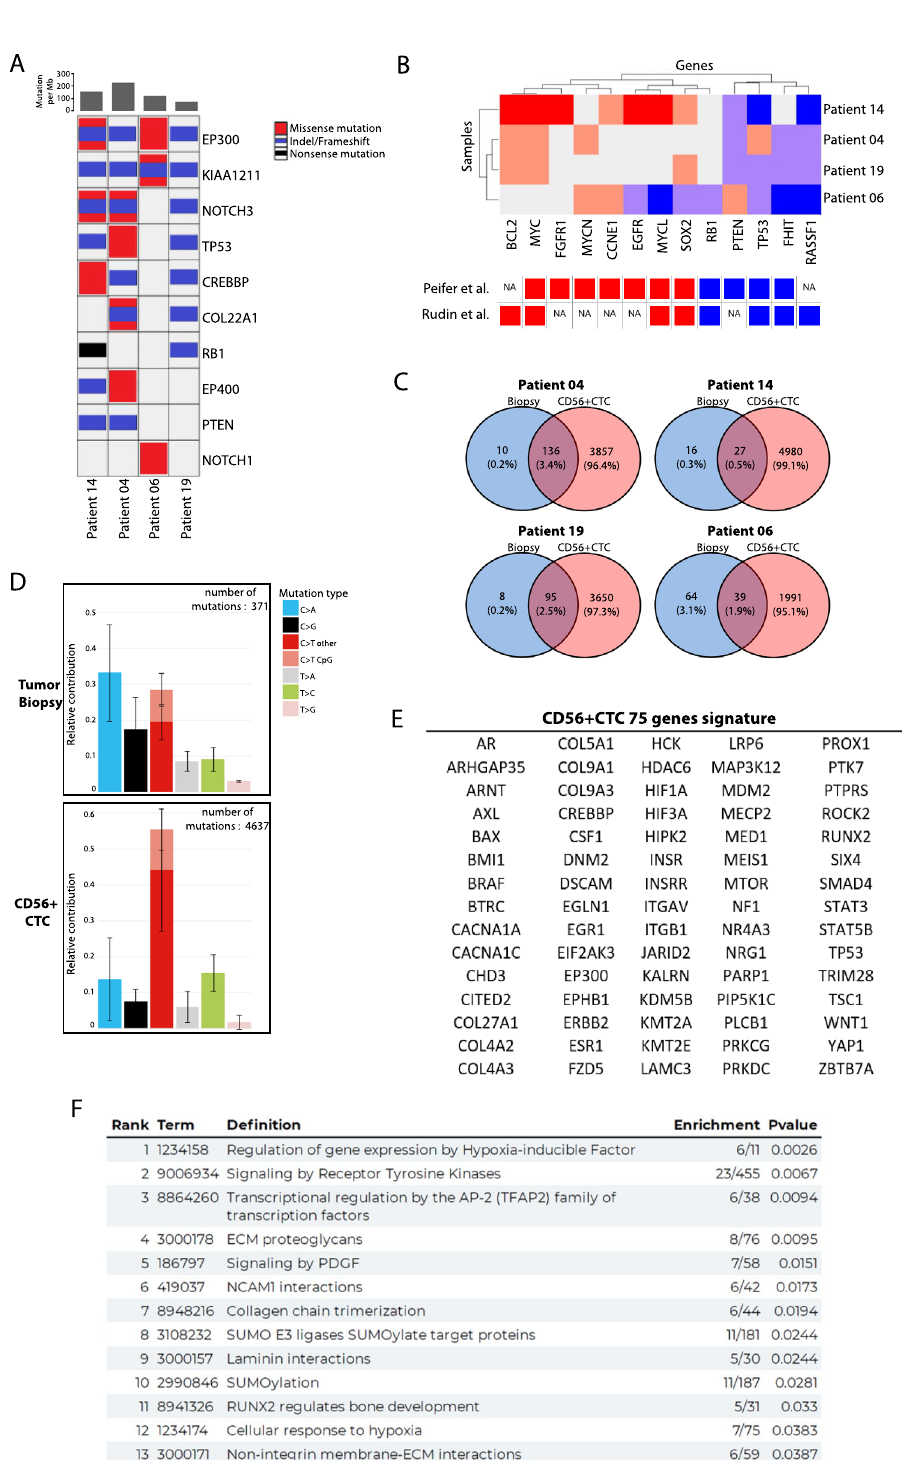
Figure 2. Genomic characterization of CD56+ CTC. ( A ) Heatmap of genomic alterations of SCLC candidate genes (CTC samples of 4 patients). Mutation rates are displayed in the top panel. ( B ) Somatic copy number alterations in CD56+ CTC (amplifications in red and deletions in blue); lower panel shows copy number alteration in published SCLC genomic studies. ( C ) Venn diagrams represent non synonymous mutations (SNPs & InDels) in biopsies and CD56+ CTCs. ( D ) Mutation spectrum plot illustrates the relative contribution of the 6 base substitution types to the point mutation spectrum for each patient sample. Bars show the mean relative contribution of each mutation type over all patient samples per sample type (biopsy and CD56+ CTC) and error bars indicate the standard deviation. ( E ) Derived genomic signature comprised of 75 genes for the CD56+ CTC at the time of diagnosis. ( F ) Analysis of the Reactome pathway of the 75 genes CD56+ CTC genomic signature (ranked according p